Question: Compose a caption that would accompany this figure in a paper.
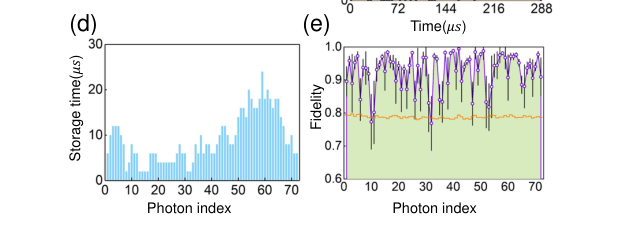
Answer: A general sequence for quantum queue. (a) A randomly generated sequence for quantum queue. (b) The input distribution and fidelity of 4 polarizations. (c) The filling number of the memory array during the experiment. (d) The storage time of 72 photons. (e) The fidelities of the retrieved photons and corresponding quantum bound (the orange lines). The error bars represent one standard devi- ation in both (b) and (e).